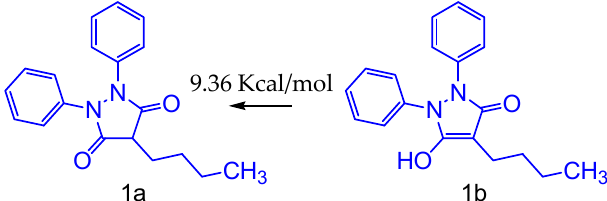
Figure 1. Tautomerism keto-enolic of phenylbutazone ( 1a ) and phenylbutazone tautomers ( 1b ).